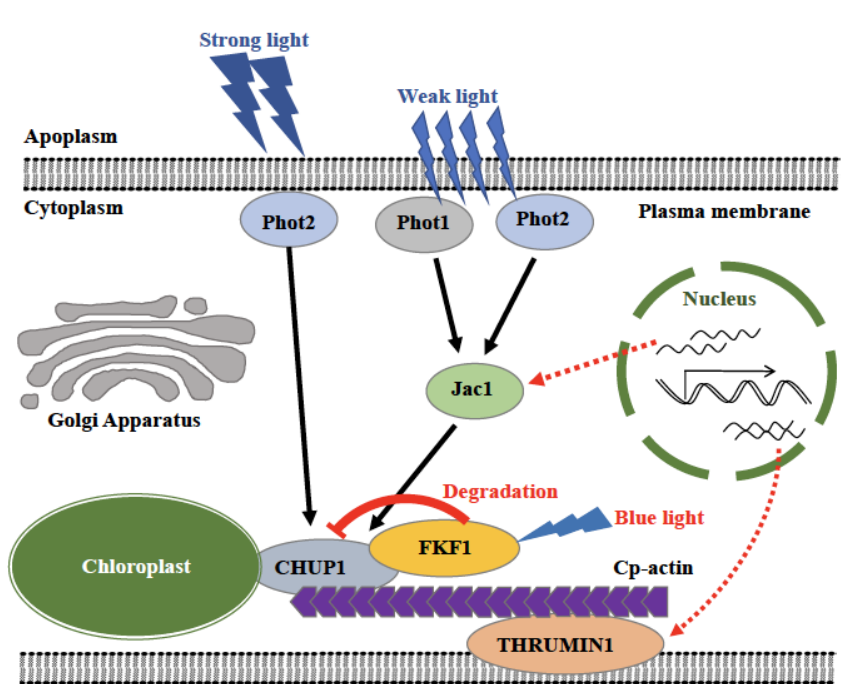
Figure 9. Model of FKF1 mediated photorelocation of chloroplasts. Phot1 and phot2 together perceive the low light and regulate the accumulation response through the JAC1 mediated signaling pathway, while phot2 alone perceives the high light and regulates the avoidance response through another signaling pathway. Upon light irradiate, FKF1 repress the avoidance response by regulating the CHUP1 protein abundance. The expression of JAC1 and THRUMIN1 are induced in the FKF1-OE line through an unknown mechanism.